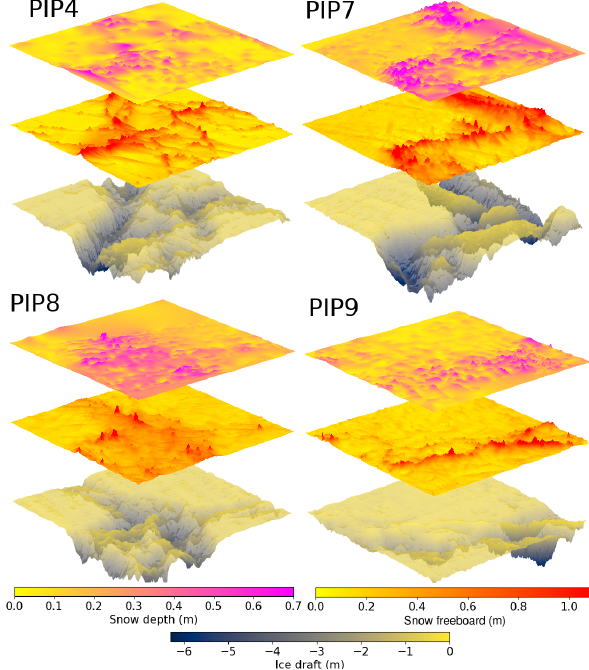
Figure 4. Sea ice–snow layer cakes from PIPERS. The top layer is the snow depth ( D ), the middle layer is the lidar scan of the snow freeboard ( F ), and the bottom layer is the AUV scan of the ice draft. The ice thickness is therefore given by ice draft + snow freeboard − snow